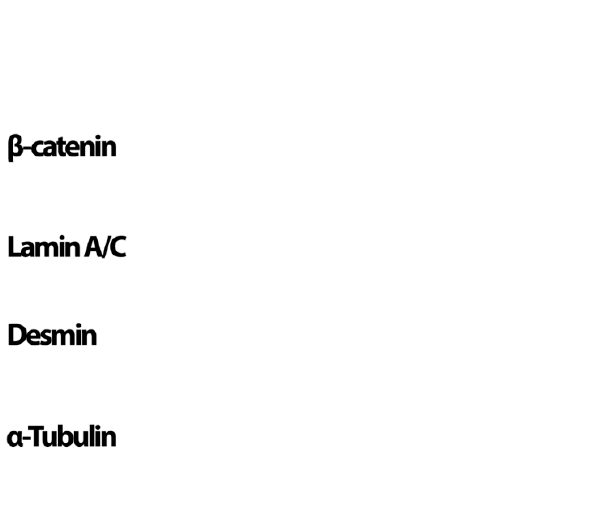
14 of 17 Figure 6. Activation of the Wnt/beta-catenin pathway can revert the effects of the downregulation of LAMP2 in chick muscle cells. Chick myogenic cells were grown for 24 h and either transfected with siRNA against LAMP2 or treated with BIO or Wnt3a. Cells were double-labeled with antibod- ies against beta-catenin (red, A – G ) and the nuclear dye NucSpot (green, A – G ). White arrows repre- sent myotubes (Myot), white arrowheads represent myoblasts (Myob), and yellow arrows represent fibroblasts (Fib). Myotube diameter decreased after the downregulation of LAMP2, whereas both